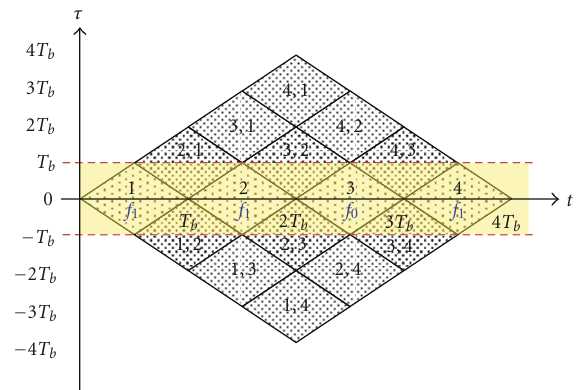
Figure 1: Bilinear product of FSK signal with lag-window. The bilinear products beyond the shaded area are removed.